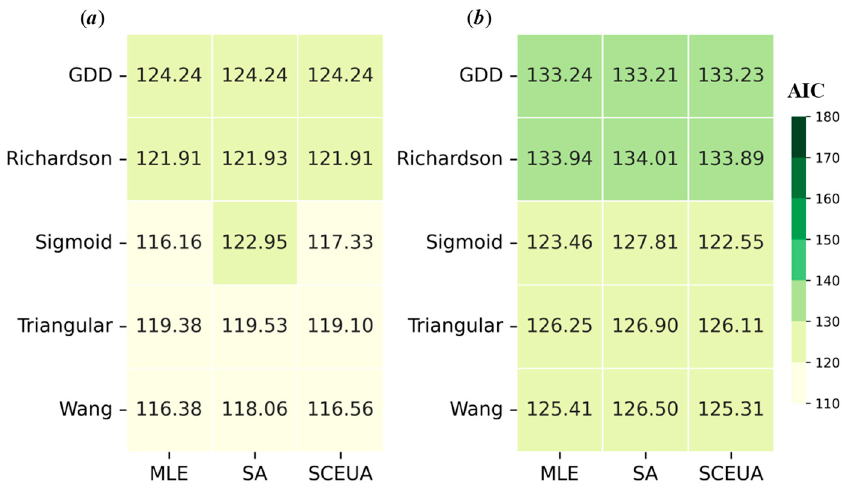
Figure 6. Evaluations with the Akaike Information Criterion (AIC) using optimized parameters over different algorithms and models for ( a ) Touriga Franca (TF) and ( b ) Touriga Nacional (TN). The lower the AIC value, the better the trade-off between the model parsimony and prediction accuracy. The analysis is carried out under the expanded lower and upper boundary of the parameter distribution by 100%, relative to the baseline